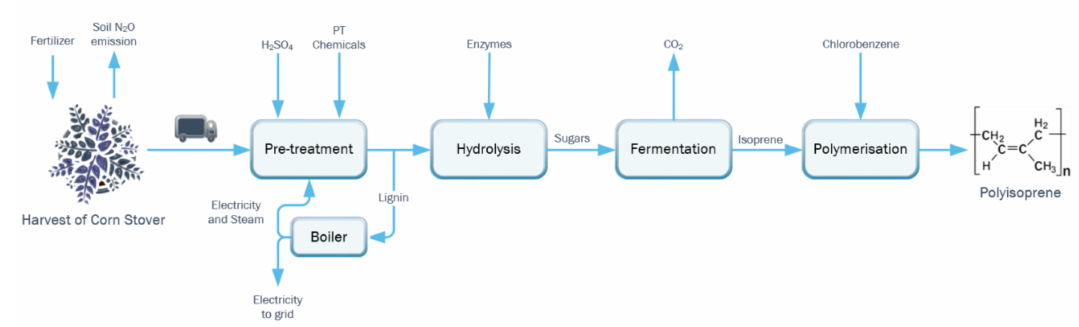
Figure 1. Cradle-to-gate life cycle process flow diagram for the production of polyisoprene from corn stover. Conversion of lignocellulosic sugars to Isoprene is simulated in UniSim design suite, which provides heat duties necessary for constructing the LCI